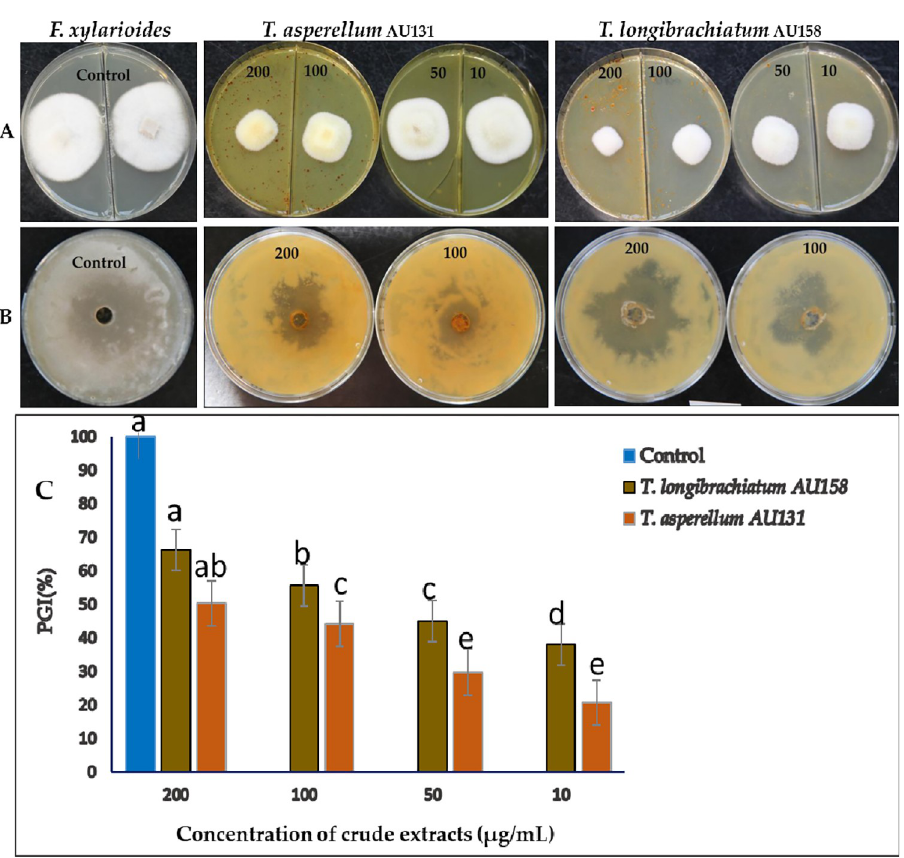
Fig 2. Bioassay activity of methanolic crude extracts of T . asperellum AU131 and T . longibrachiatum AU158 against F . xylarioides . A and C: Seeded agar assays: The picture shows the antifungal activity at different concentrations (200, 100, 50 and 10 μ g/mL of crude extracts amended with PDA medium) and B : Agar diffusion assays (200 and 100 μ g/mL of crude extracts). Different alphabets depicted in superscript indicate mean treatments that are significantly different according to Tukey’s HSD posthoc test at p � 0.05, each value is an average of 3 replicate samples ± standard error. PGI = percentage of growth